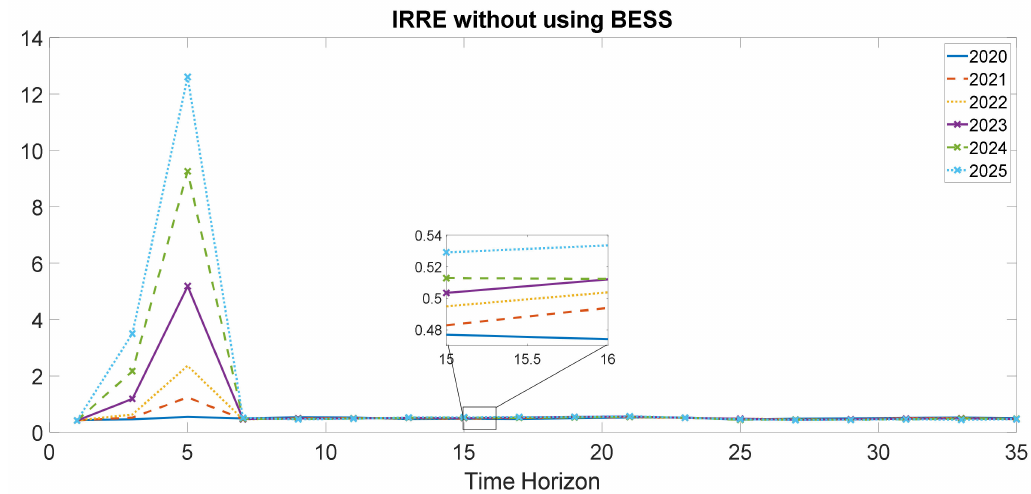
Figure 3. IRRE without a BESS installed for the years 2020–2025.